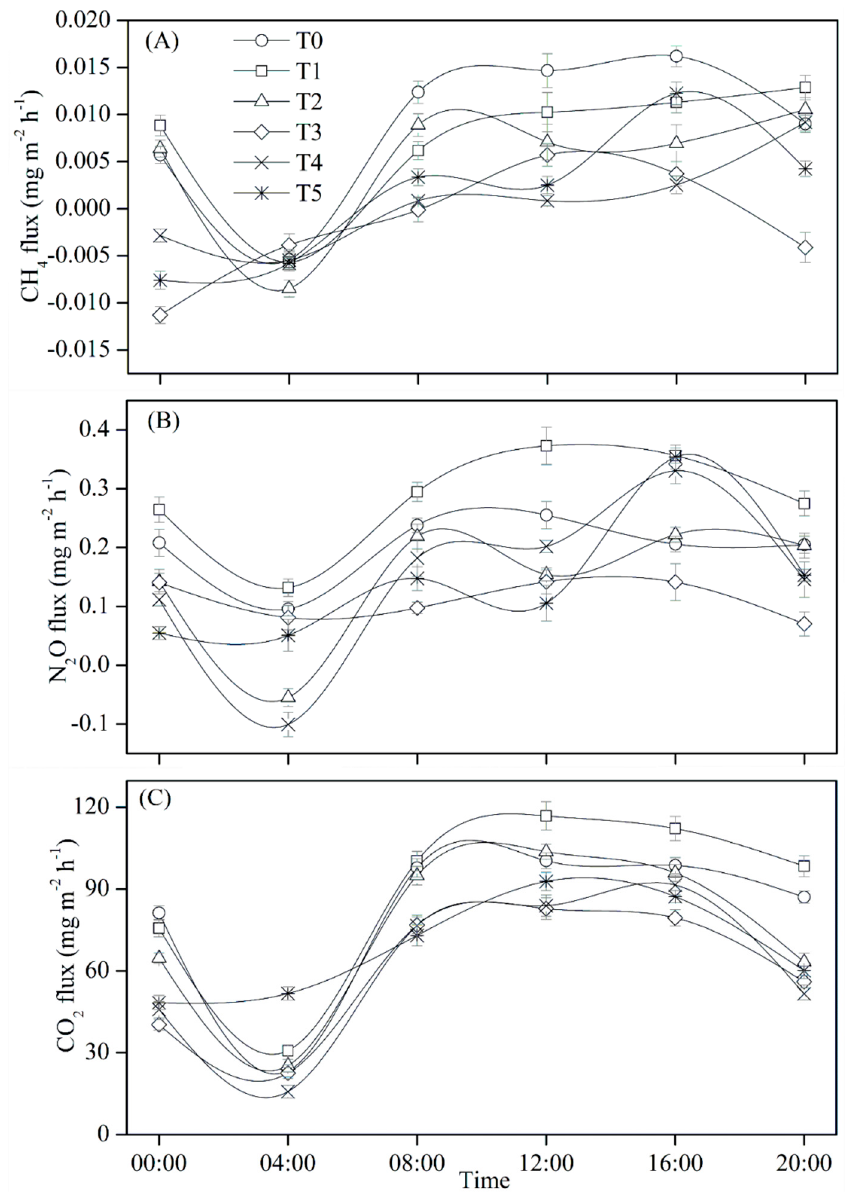
Figure 2. Diurnal variations of CH 4 ( A ), diurnal variations of N 2 O ( B ) and diurnal variations of CO 2 ( C ) fluxes respectively for spring wheat measured during the growing season of 2015. Bars indicate standard errors (SE) at p < 0.05. Treatments are biochar applied at 0, 10, 20, 30, 40, and 50 t ha − 1 (corresponding to T0, T1, T2, T3, T4, and T5), respectively.